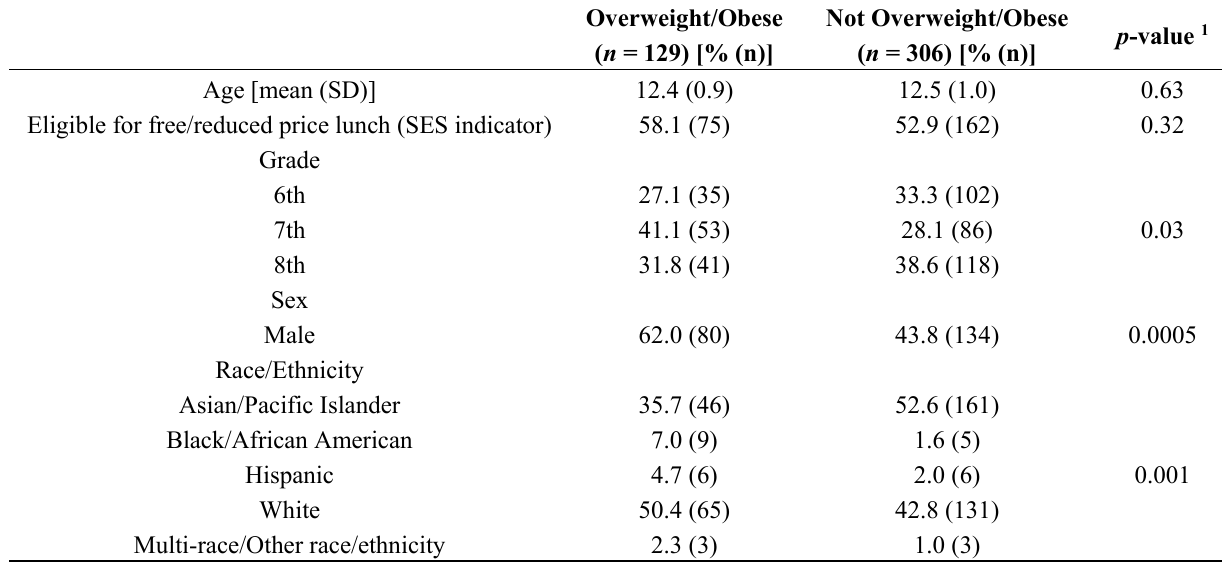
Table 2. Sample Characteristics by Overweight Status, Study Sample ( n =